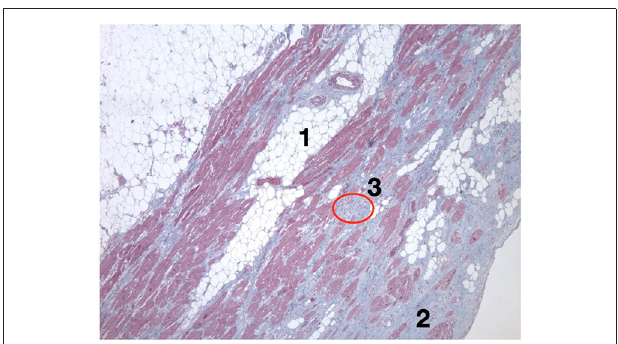
FIGURE 1 | Histological view of the left ventricle of a heart with biventricular arrhythmogenic cardiomyopathy due to the TMEM43 S358L mutation. This patient suffered a sudden cardiac death while practicing sports. The histological hallmarks that define the disease are shown, such as myocardial loss due to fatty infiltration (1) and fibrosis (2); additionally, lymphocytic infiltrates can be observed (3). TMEM43, transmembrane protein